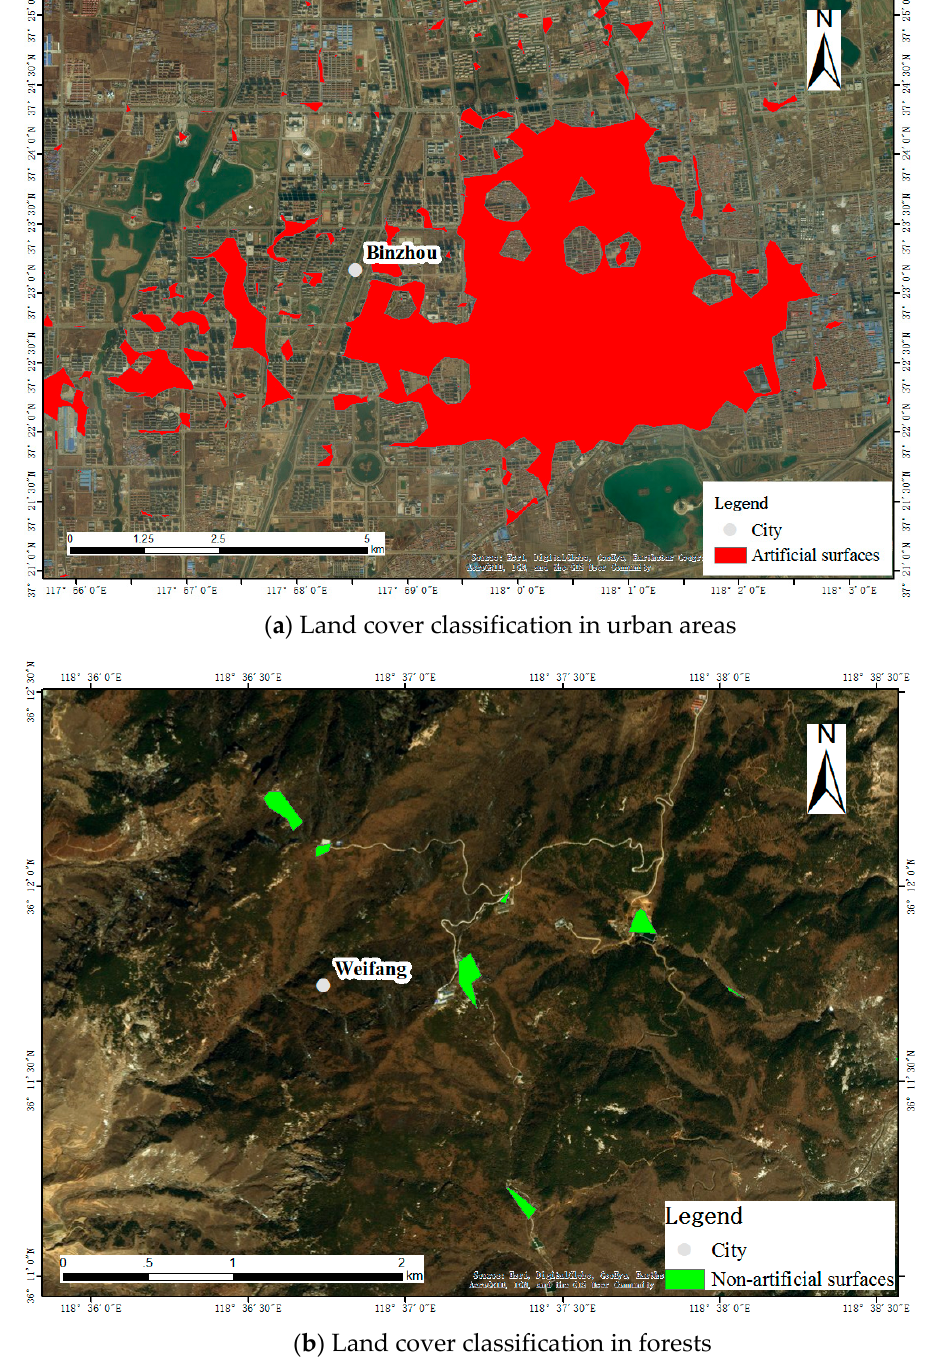
Figure 12. Land cover classification based on extracted regions in two areas in Shandong Province.